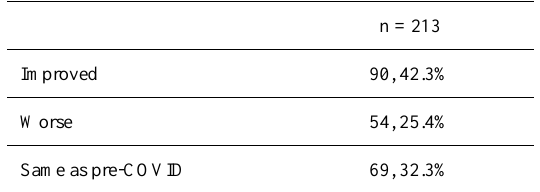
Table 2. Communication between team-members during